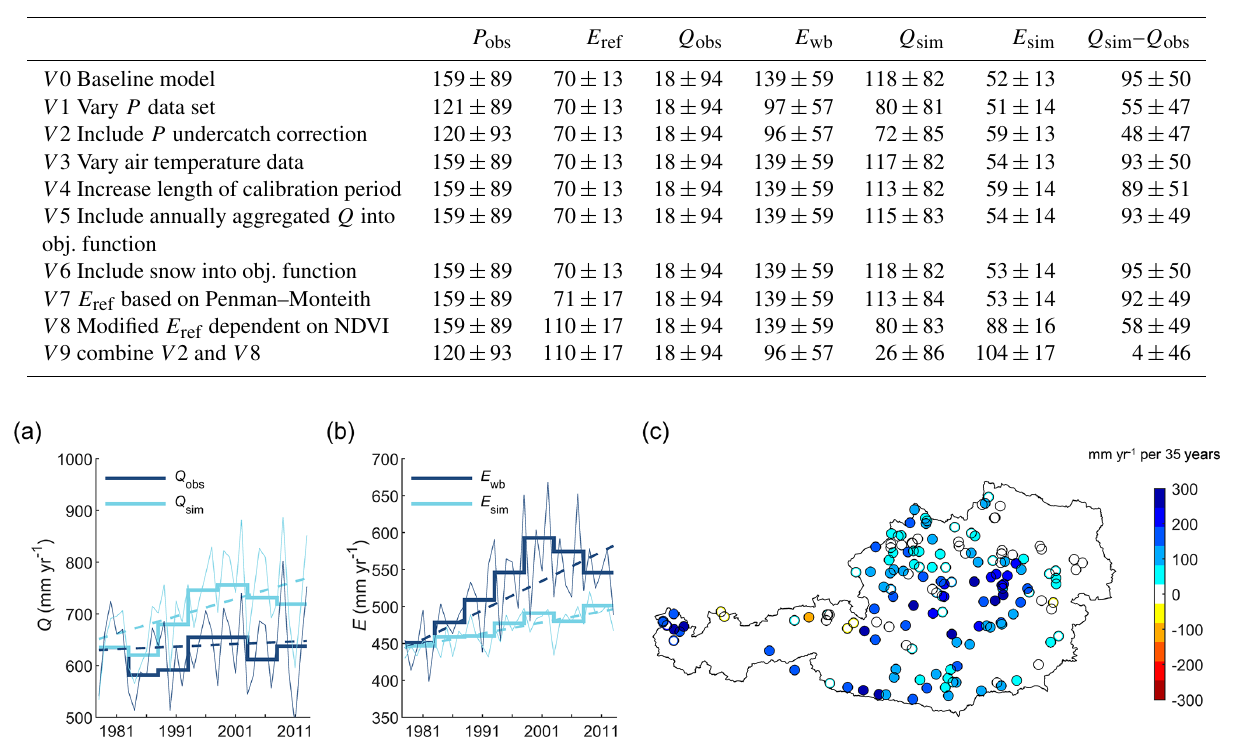
Table 4. Linear trends in water balance components (mmyr − 1 per 35 years) over 1978–2013 as averages over all catchments. Simulated values refer to the model calibrated in subperiod S 1 (1978–1982). Uncertainties relate to standard deviations of the trend slope averaged over all catchments. For trends in Q sim – Q obs , we first derived series of the differences Q sim – Q obs for each catchment and then estimated trends.